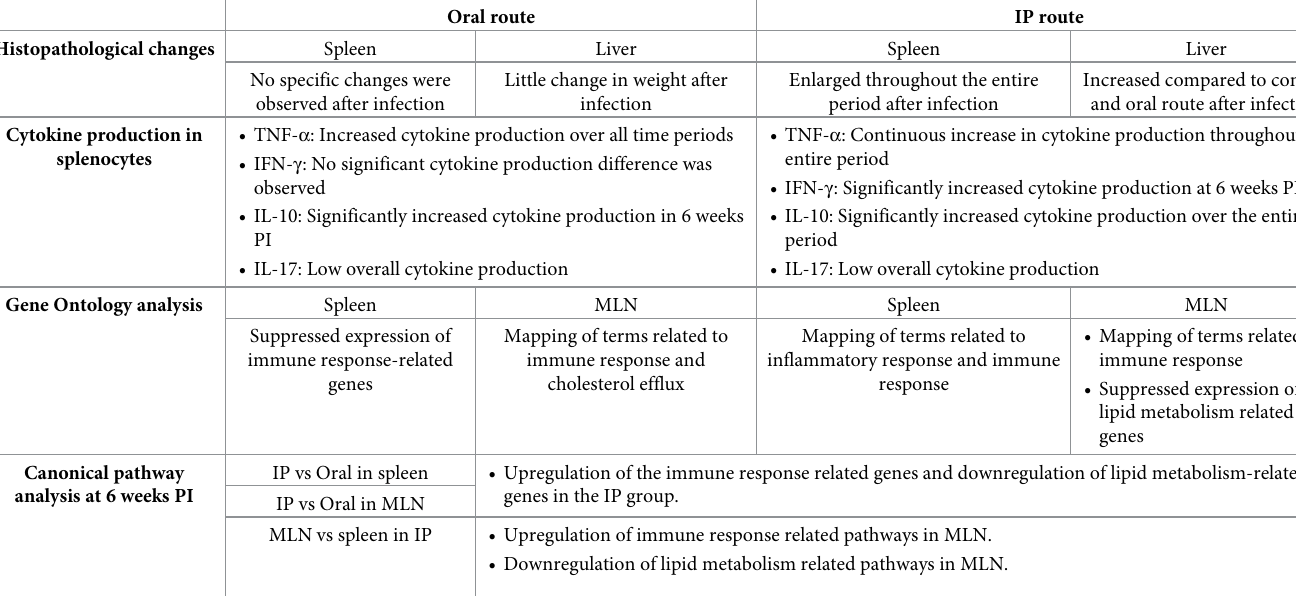
Table 2. Comparison of pathological, immunological and gene expression in mice infected oral or IP with